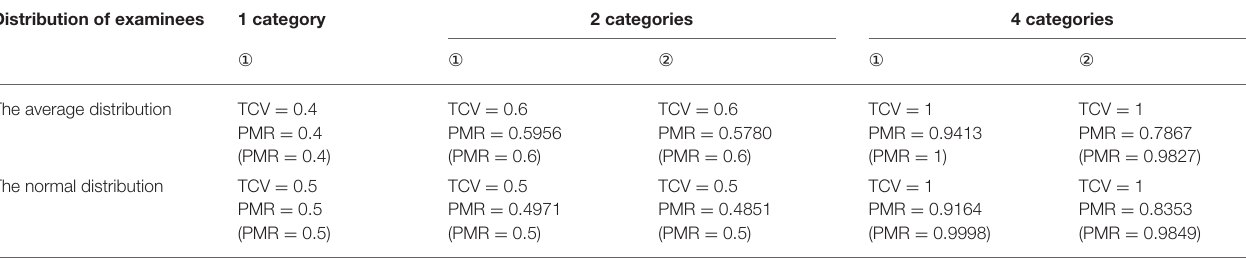
TABLE 3 | The comparison between the TCV and the PMR ORP of the linear